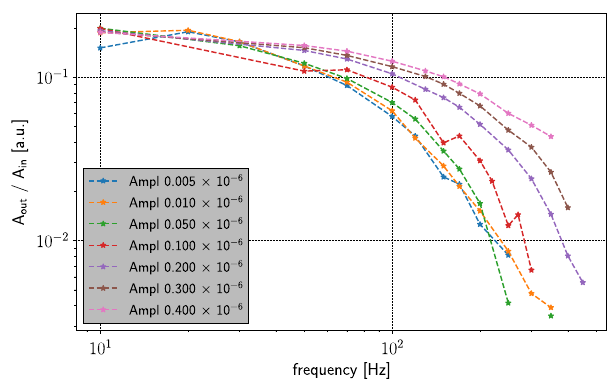
FIG. 6. Fixed amplitude transfer functions from the rectified derivative of the focusing quadrupole strength to the extracted spill. The injected sinusoidal amplitudes are reported in the legend in units of m − 2